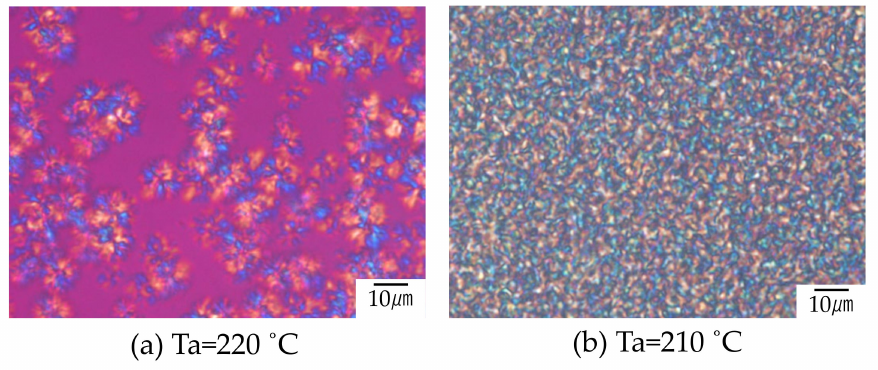
Figure 6. Crystalline morphology of 60 / 40 PTT / PET at di ff erent annealing temperatures: ( a ) Ta = 220 ◦ C and ( b ) Ta = 210 ◦ C.